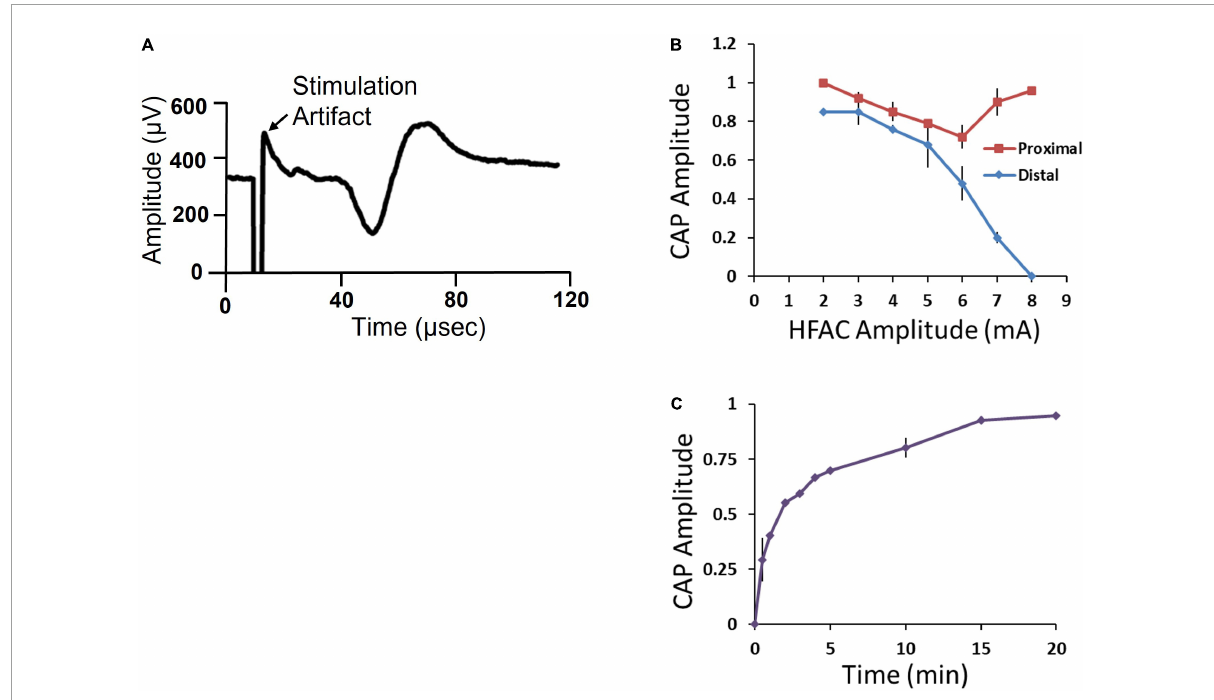
FIGURE7 Isolated swine sub-diaphragmatic vagus nerve electrophysiology demonstrated conduction block and recovery at a high frequency alternating current (HFAC) amplitude of 8 mA. (A) Representative compound action potential (CAP) elicited by electrical stimulation at the level below the diaphragm and recorded at a segment below the heart. The length of the isolated vagus nerve was approximately 35 mm. (B) Current-effect curve of CAP amplitude elicited from the proximal and distal stimulation electrodes immediately following the cessation of HFAC. CAP amplitude was normalized to baseline. (C) Recovery of CAP amplitude following full block. Error bars are